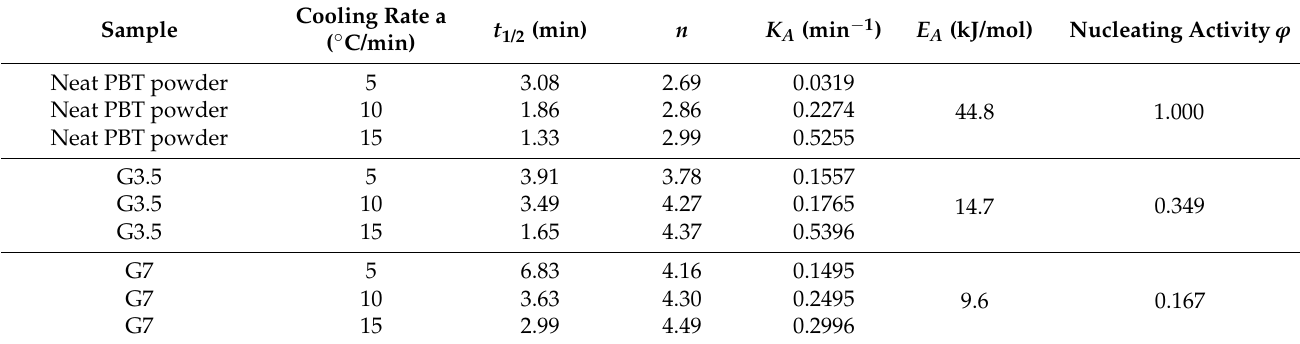
Figure 5. Avrami-type plots for pure PBT, G3.5 and G7 vitrimers (3 h at 180 °C with X t ranging from 2 to 95%, at each cooling rate: ( a ) 5 °C/min, ( b ) 10 °C/min and ( c ) 15 °C/min. Table 4. Crystallization parameters for the neat PBT, G3.5 and G7 vitrimers at the optimum SSP conditions (3 h at 180 ◦ C).